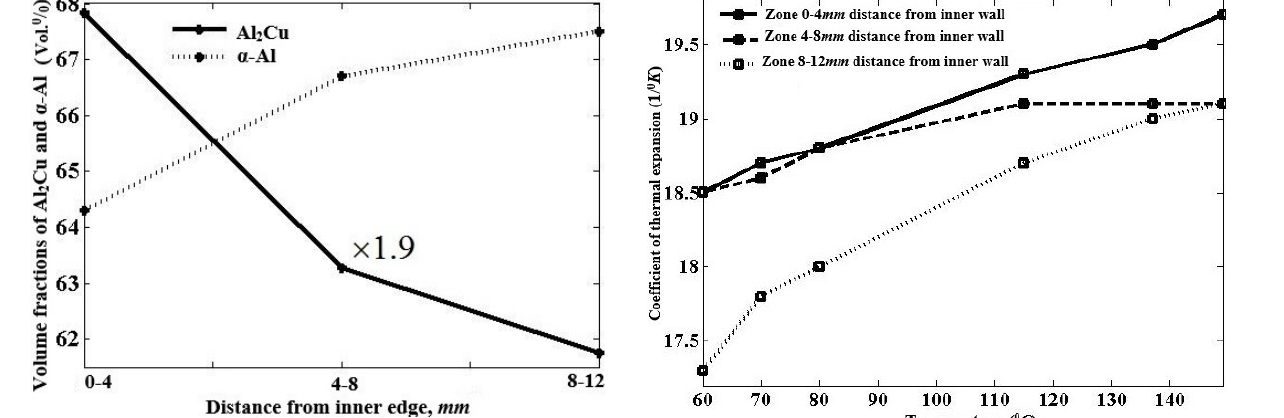
Figure 7: Variation of CTE with temperature for different section